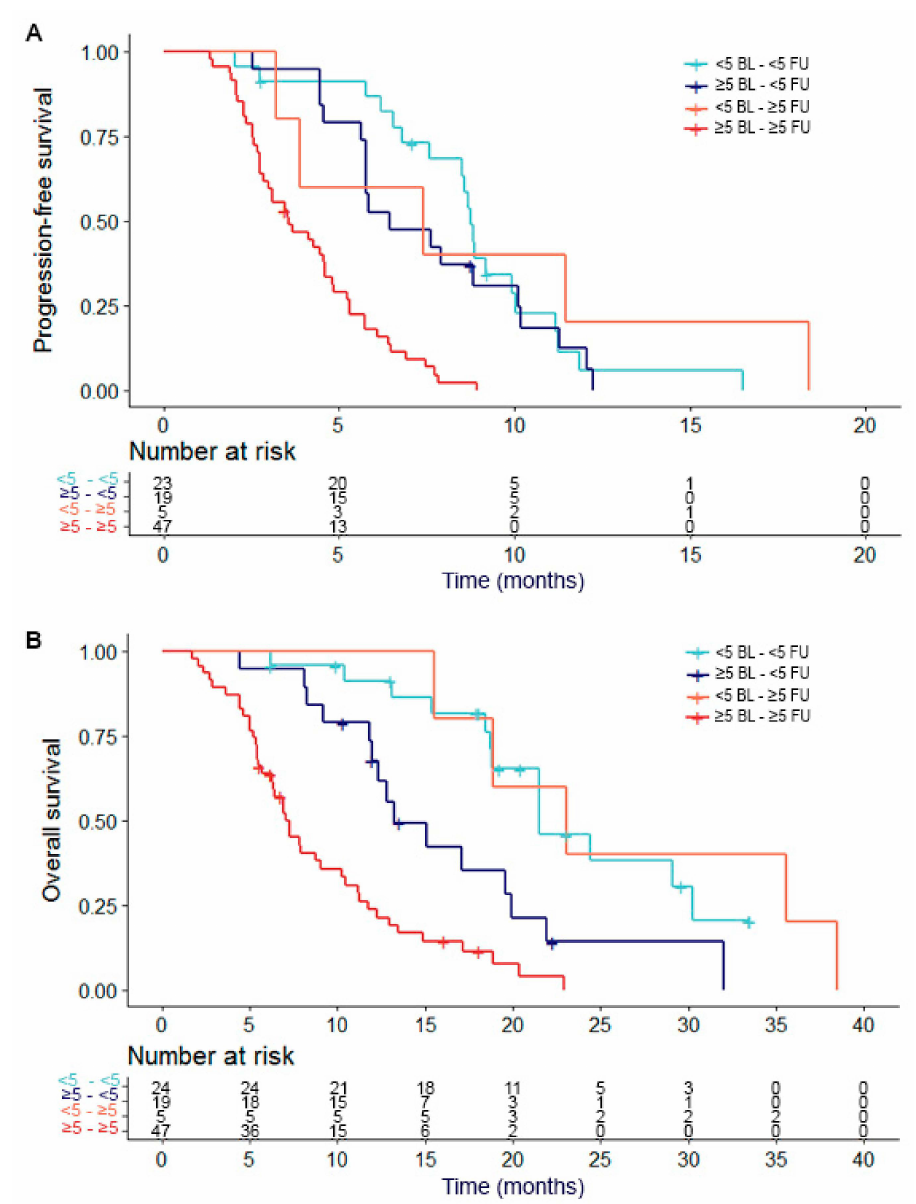
Figure 2. PFS and OS in relation to CTC groups. Kaplan Meier curves of ( A ) progression-free survival (PFS) and ( B ) overall survival (OS) in relation to circulating tumor cell (CTC) count. CTC counts are divided into four categories: (1) < 5 CTCs at baseline and < 5 CTCs during treatment, (2) ≥ 5 CTCs at baseline and < 5 CTCs during treatment, (3) < 5 CTCs at baseline and ≥ 5 CTCs during treatment and (4) ≥ 5 CTCs at baseline and ≥ 5 CTCs during